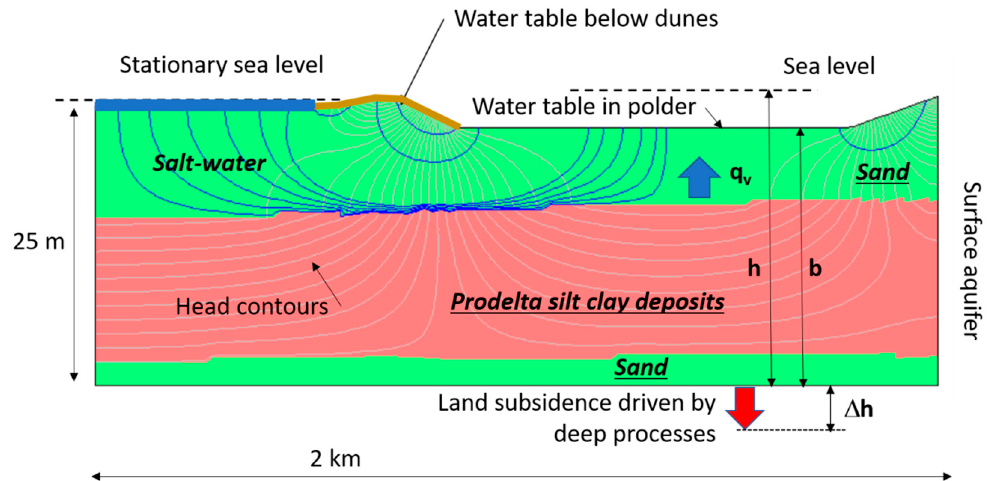
Figure 4. Cross section representing the hydraulic conceptual model of the aquifer. The boundary conditions (sea level, water table in the aquifer) are shown. A steady state simple finite element model shows the vertical flow lines below the polder (blue line). Due to land subsidence driven by deep processes, the aquifer translates vertically downward; this increases the vertical hydraulic gradient and seepage.